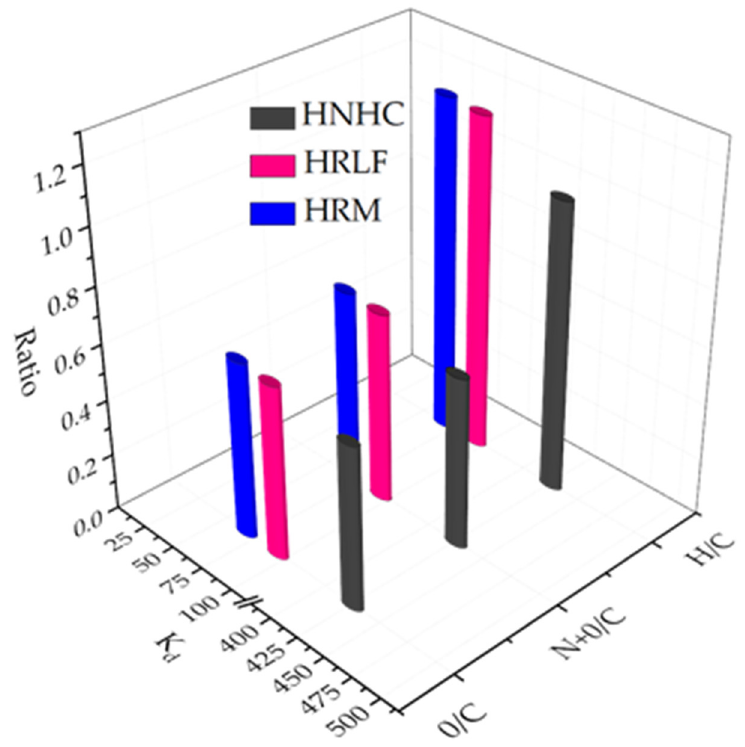
Figure 11. Relationship between adsorption coefficient K d of HRM, HRLF and HNHC and H/C, (N+O)/C, O/C.